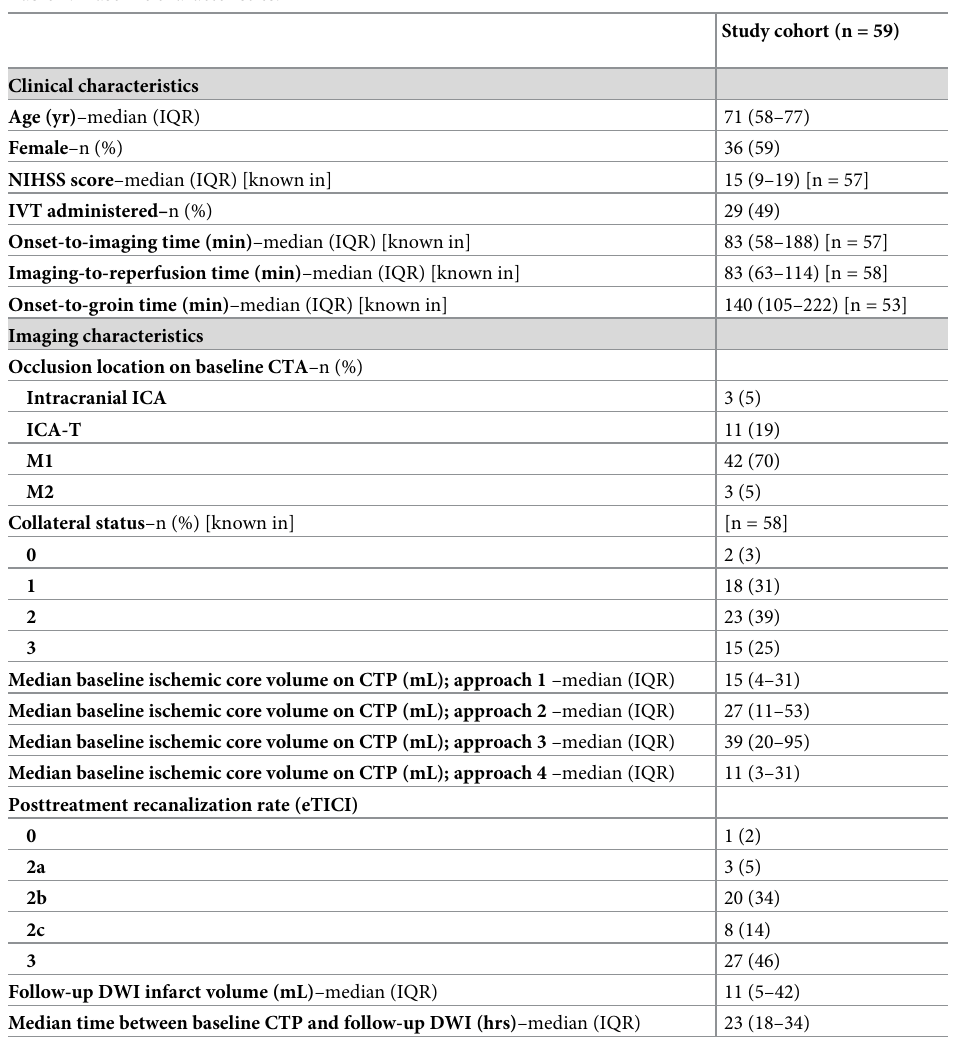
Table 1. Baseline